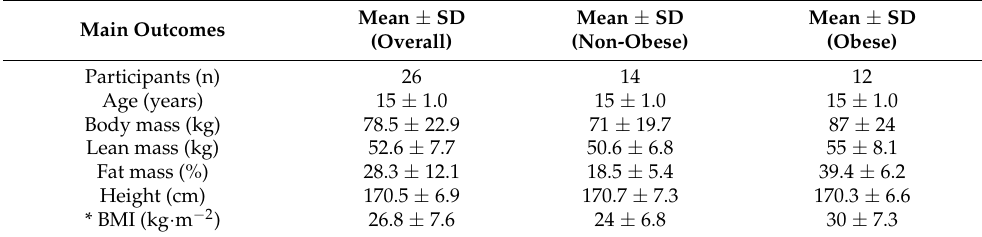
Table 1. Characteristics of the